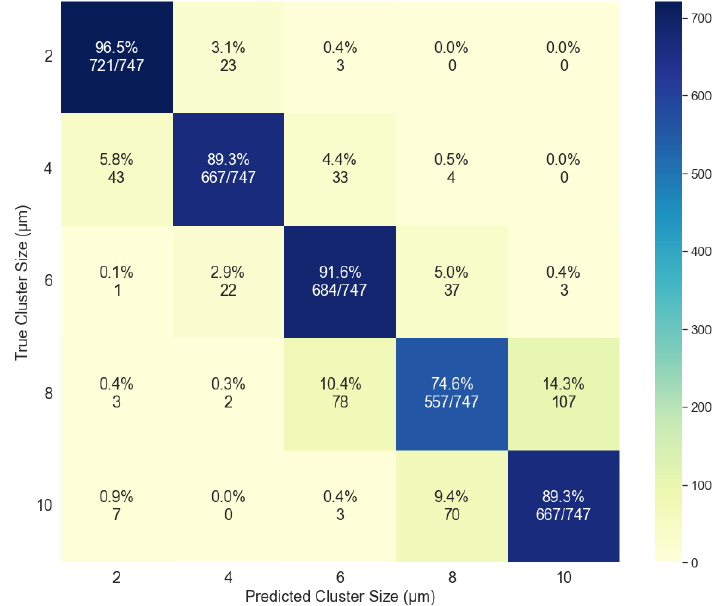
Figure 8. Confusion matrix for the classification based on cluster size using the forward scattering data for the analysis.